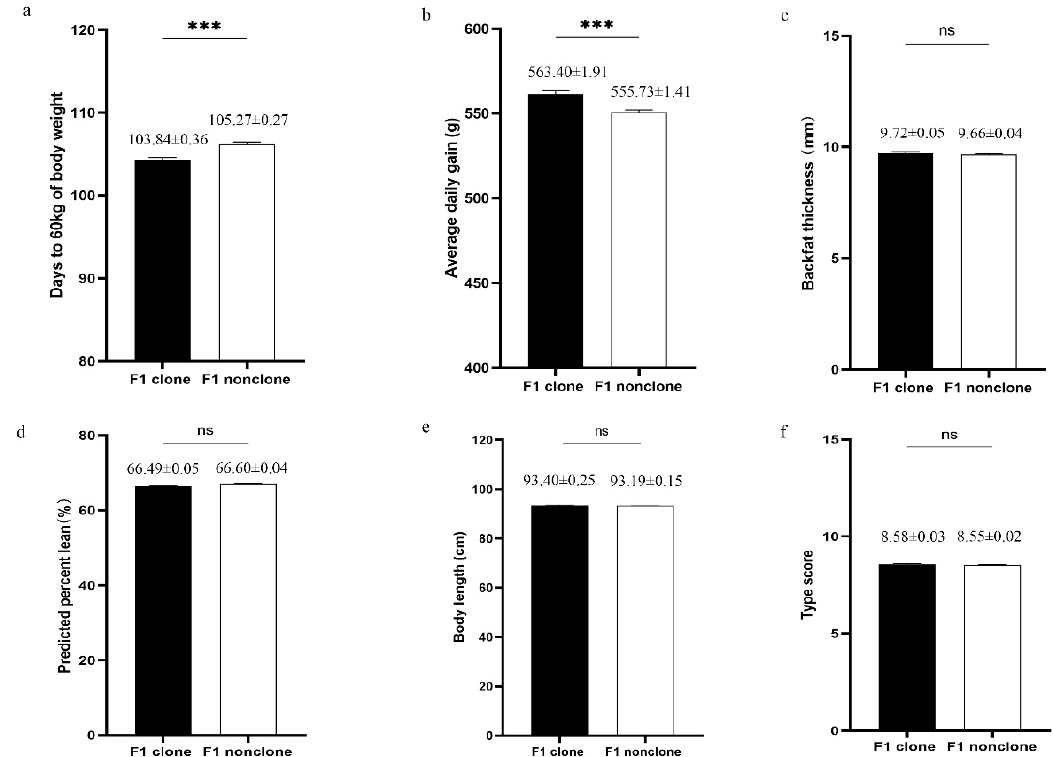
Figure 3. Growth performance of F1 progeny of clones ( n = 466) and F1 progeny of non-clones ( n = 822). ( a ) Adjusted days to 60 kg of body weight; ( b ) Average daily gain from birth to adjusted 60 kg of body weight; ( c ) Backfat thickness adjusted to 60 kg of body weight; ( d ) Predicted percent lean. ( e ) Body length; ( f ) Type score. ***stands for p ≤ 0.001, ns stands for nonsignificant differences. F1 clone stands for the F1 progeny of clones. F1 nonclones stands for the F1 progeny of non-clones.